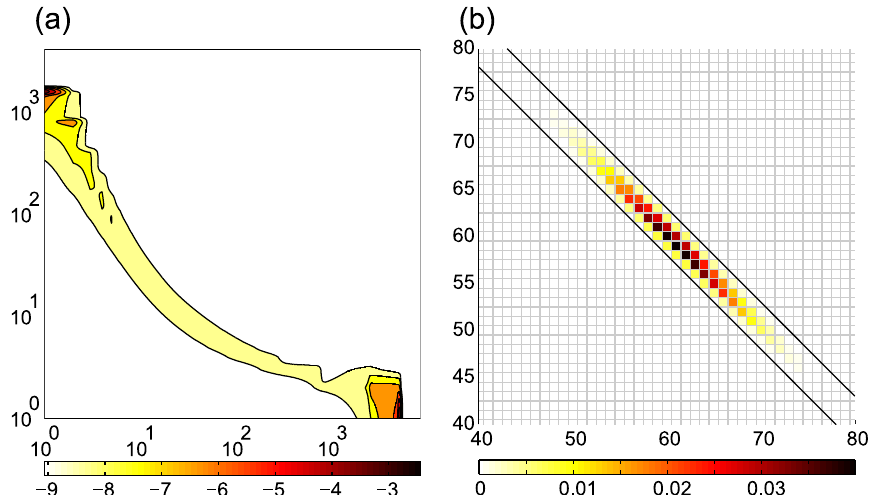
Figure 5. Snapshots of solutions. (a) Genetic toggle switch. The PDF for m ~ 350 , t m & 10 : 18 , U (hor.) vs. V (vert.). As the process evolves, the probability mass becomes concentrated in two distinct regions. Contour coloring is logarithmically scaled with base 10 . (b) Enzymatic futile cycle. The marginal PDF for m ~ 20 , t m ~ 5 : 10 { 3 , X (vert.) vs. X (cid:3) (hor.). Black diagonal lines delimit the states reachable from the initial condition. The transposed QTT format automatically exploits this sparsity pattern of the full PDF for compression without special input from the user.